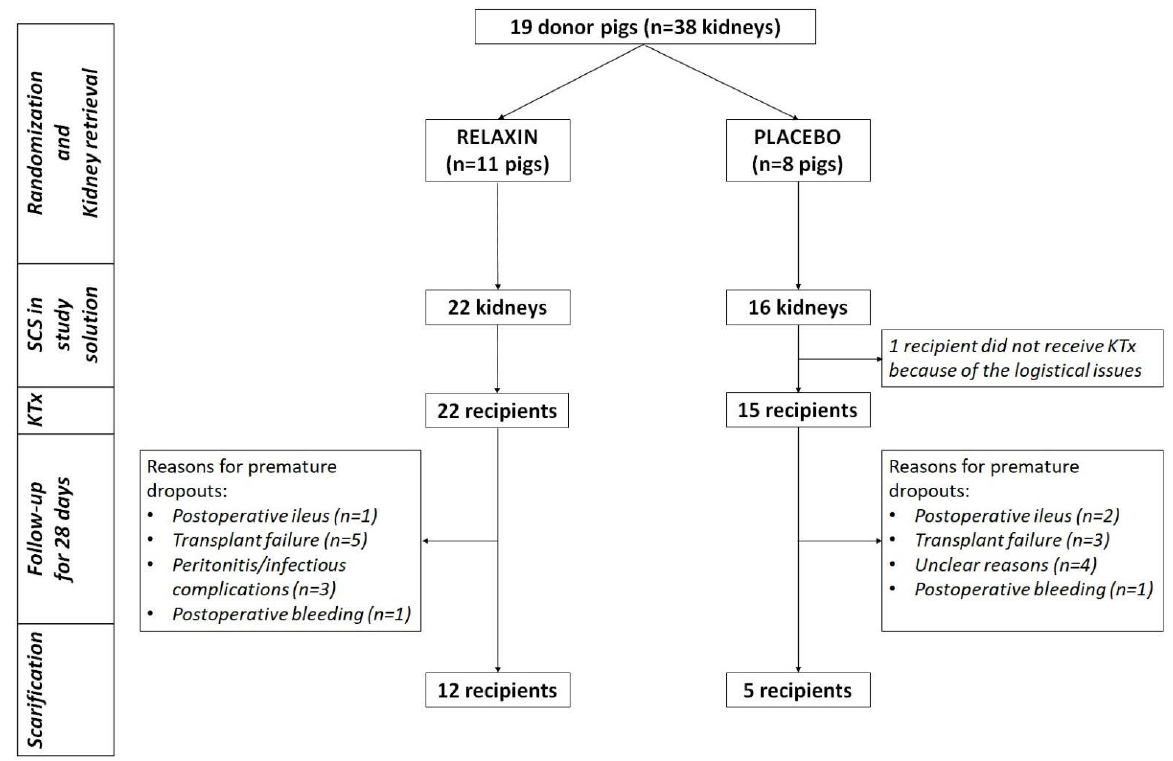
Figure 1. Flowchart study design. SCS: static cold storage; KTx: kidney transplantation.